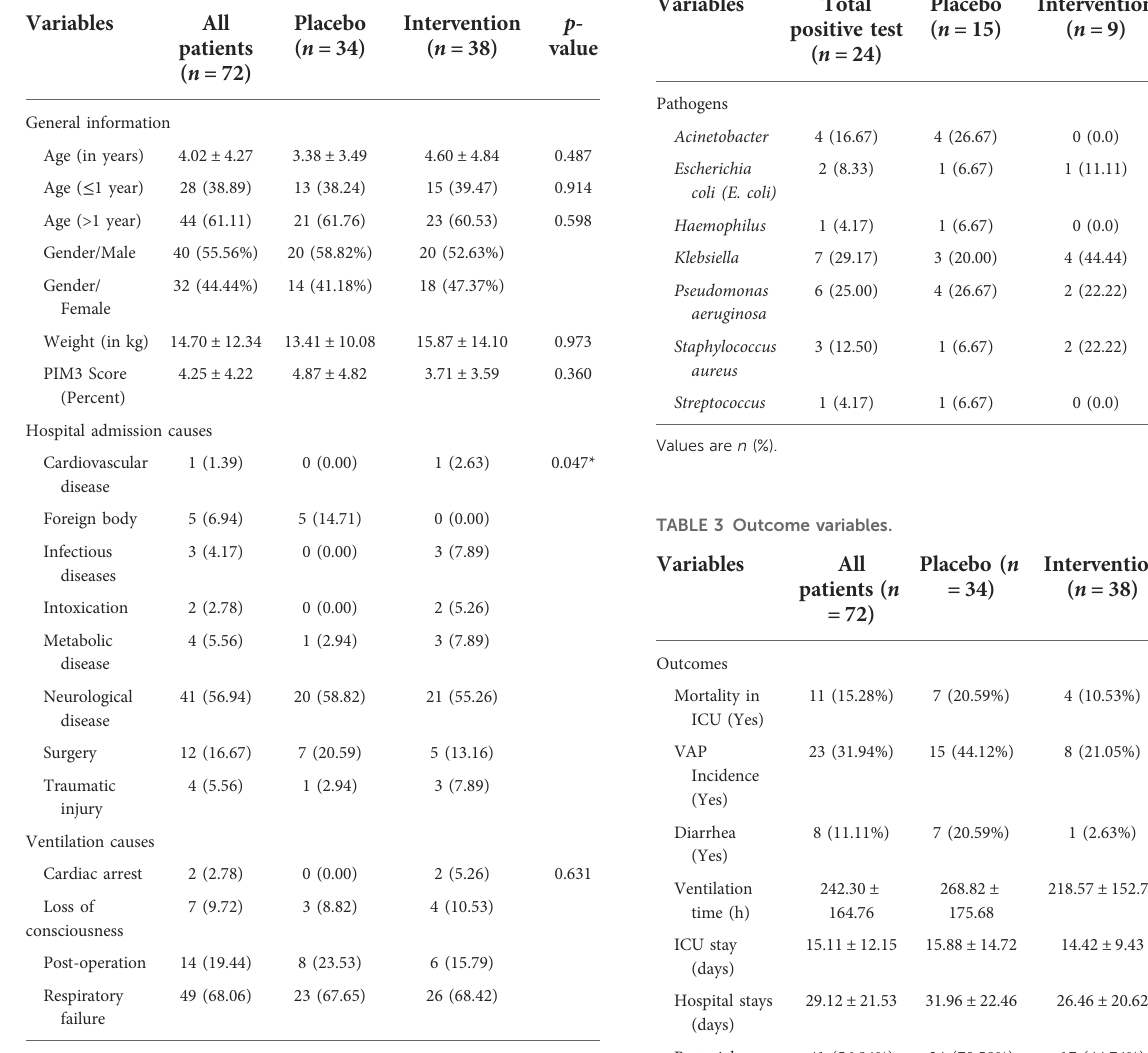
TABLE 2 Types of organisms from mini-BAL. TABLE 1 Baseline characteristics between intervention and placebo